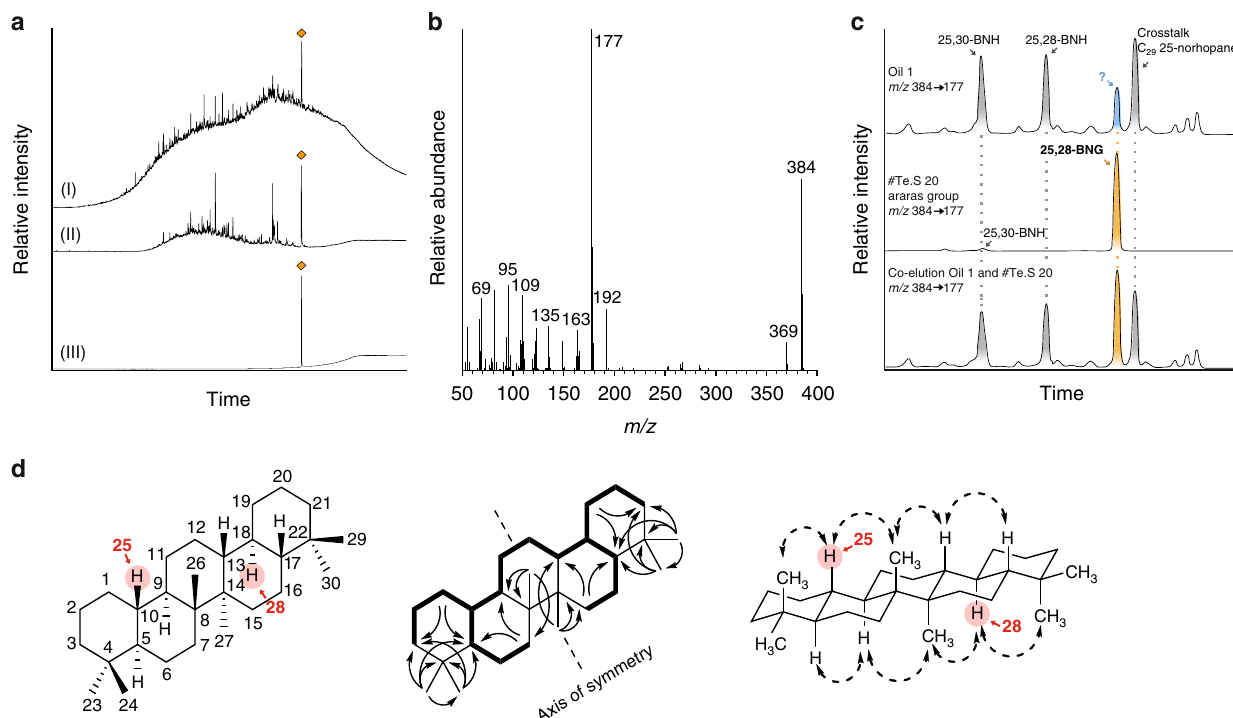
Fig. 2 Isolation, characterisation and chemical structure of 25,28-bisnorgammacerane (BNG). a Total ion gas chromatography (GC)-mass spectrometry chromatograms (TIC, m / z 50 – 550) showing the stepwise isolation of BNG (orange diamonds): (I) the initial saturated hydrocarbon fraction, (II) the remaining fraction containing BNG after molecular sieving and preparative liquid chromatography, and (III) the isolated fraction after preparative gas chromatography containing BNG at >99% purity. b Mass spectrum (electron impact: 70 eV) of BNG (C 28 H 48 , m / z 384). c Co-elution experiment by tandem mass spectrometry ( m / z 384 → 177), using a GC-tandem mass spectrometry system equipped with a DB-1-MS column, of an oil sample (top) and a sample containing abundant BNG (Te.S 20; see Fig. 1 for identi fi cation), verifying the presence of BNG in the oil (bottom). d Chemical structure of BNG (5 α (H),8 β ,9 α (H),10 β (H),13 β (H),14 α ,17 β (H),18 α (H)); red numbers indicate positions 25 and 28 determined based on 1 H- 1 H correlated spectroscopy (bold), heteronuclear multiple-bond correlation (H → C) and nuclear Overhauser effect spectroscopy (also see Supplementary Methods)